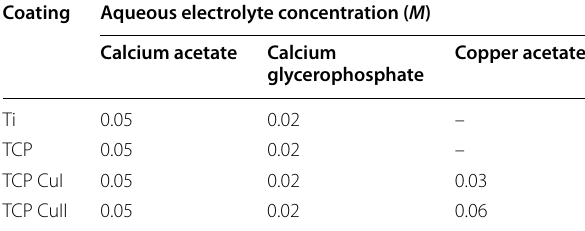
Table 1 Electrolyte composition of different coatings Coating